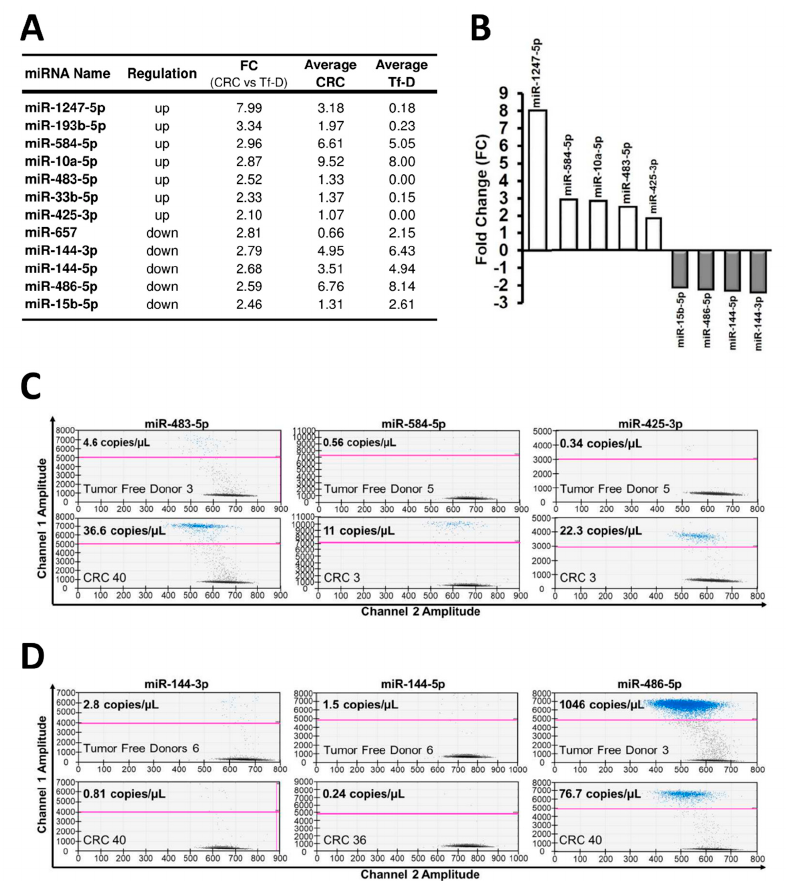
Figure 3. miRNA selected for digital droplet RT-PCR validation. ( A , B ): List of the candidate miRNAs chosen for dd-RT-PCR validation. Up- and down-regulation levels are indicated. ( C , D ): Representative plots of dd-RT-PCR analysis. The full dd-RT-PCR data (copies/µL) are reported in Figure 4.